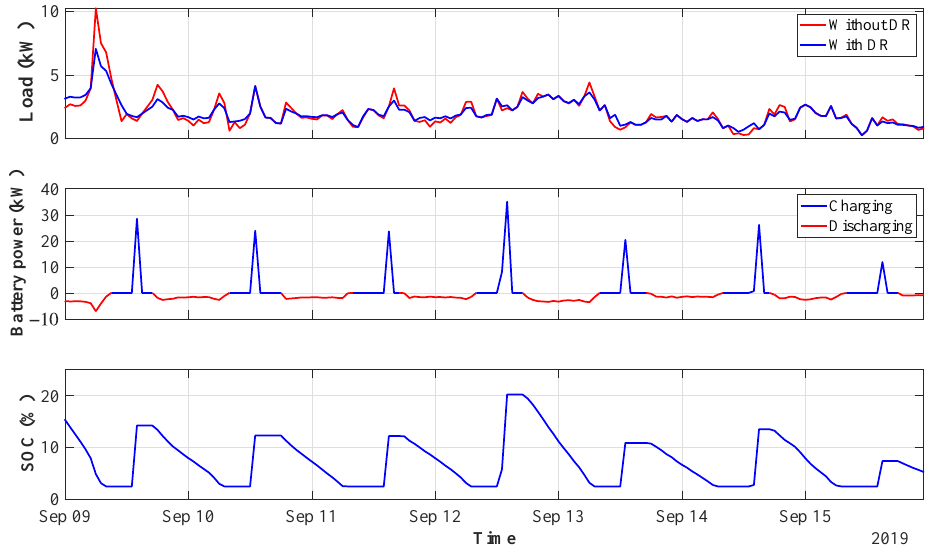
Figure 14. DR and BESS in late